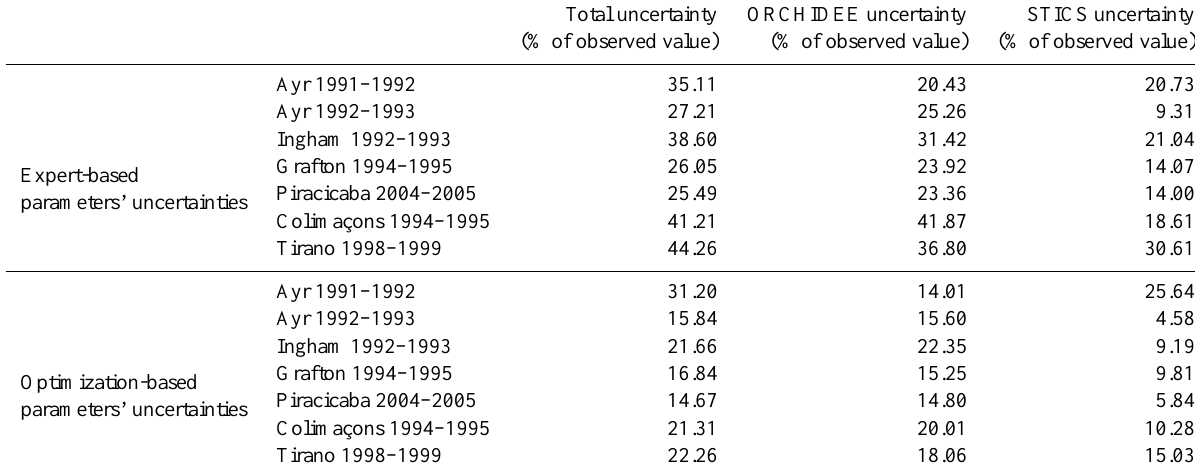
Table 3. Uncertainty associated with STICS, ORCHIDEE, or ORCHIDEE + STICS parameters uncertainties expressed as percentage of the reference harvested biomass for each site and for each of the two uncertainty analysis. Total uncertainty ORCHIDEE uncertainty STICS uncertainty (% of observed